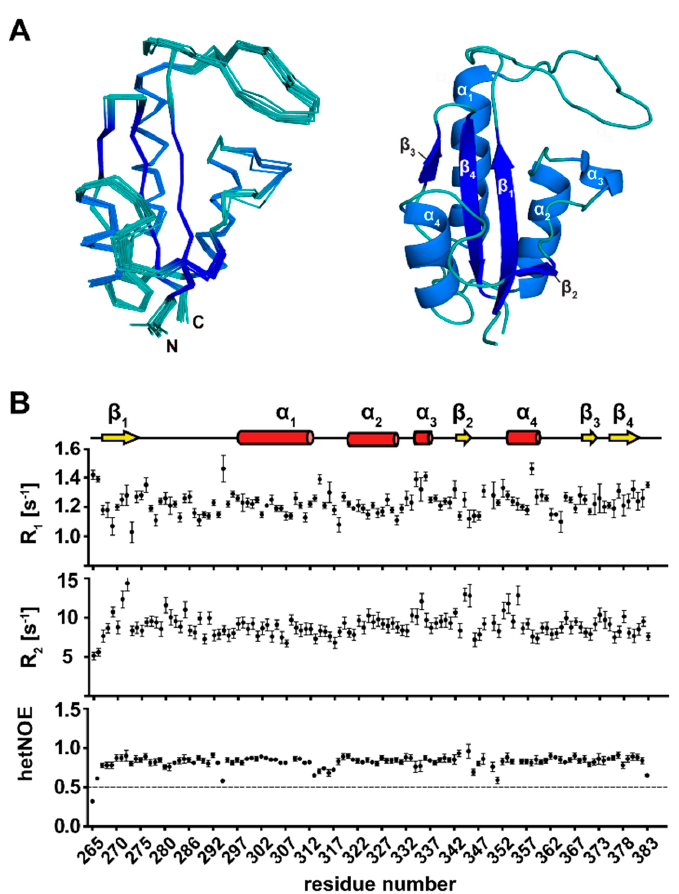
Figure 2. Structural and dynamical data of the PPIase domain of Tb Par42. ( A ) Ensemble of the 10 lowest energy structures (left) and ribbon representation of Tb Par42-PPIase (right). The four α -helices and four β -sheets of the parvulin fold are indicated. ( B ) Dynamics of the PPIase domain. The secondary structure elements are indicated at the top of the plot. Below, the longitudinal (R1) and transversal (R2) relaxation rates, as well as the HetNOE of the amino group of residues, within the domain are plotted .